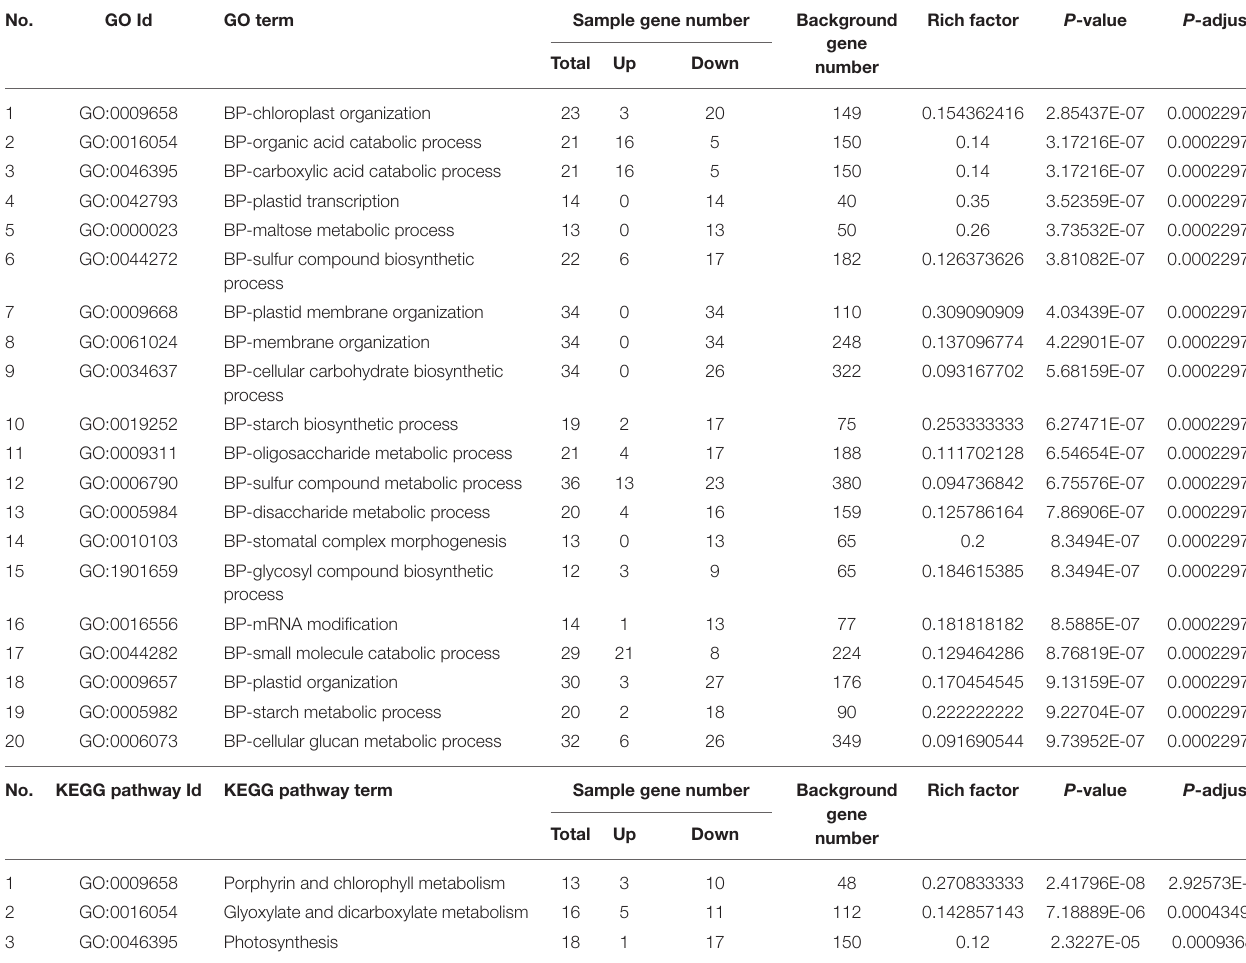
TABLE 1 | Gene ontology enrichment and Kyoto encyclopedia of genes and genomes pathway enrichment analysis of SAGs ( Figure 4D , 1546 genes) shared by darkness and salt-induced leaf senescence at three time points.